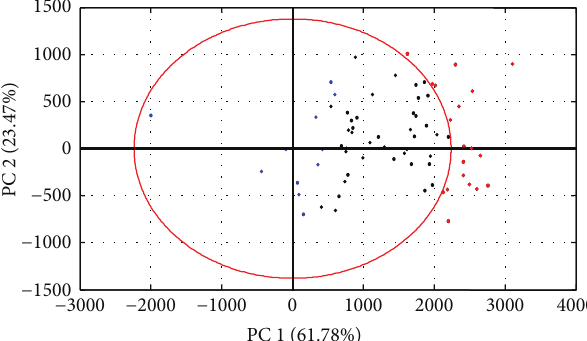
Figure 3: PCA projection plot for other batches of samples relative to the samples in the reference class. The blue dots represent the samples in the reference class; the black dots refer to the batches of samples with no significant differences to the centroid of the reference class; the red dots denote the batches of samples having significant differences to the centroid of the reference class. Red ellipse is drawn at 95% probability ( 𝛼 = 0.05